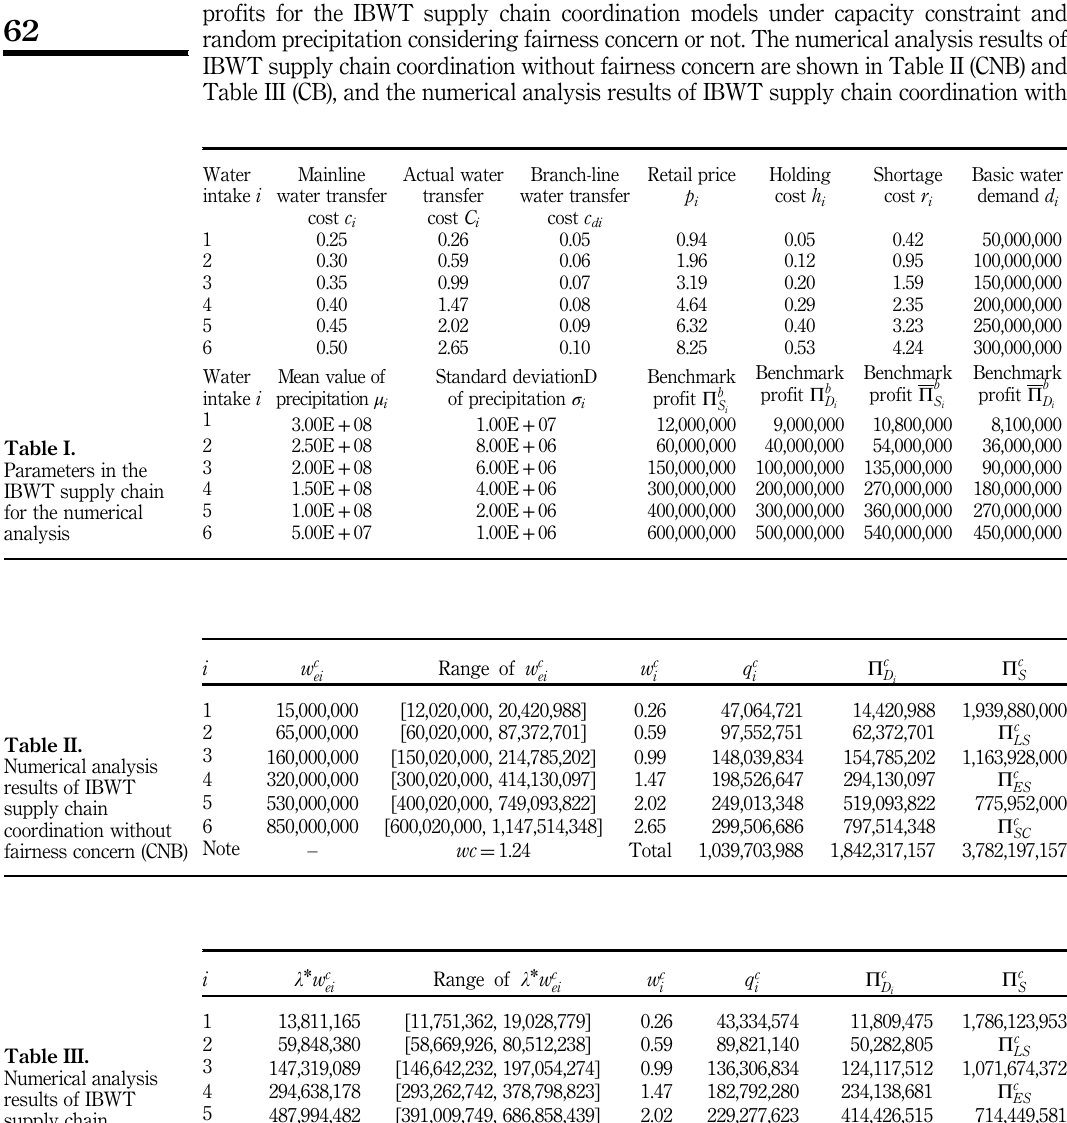
Table III. Numerical